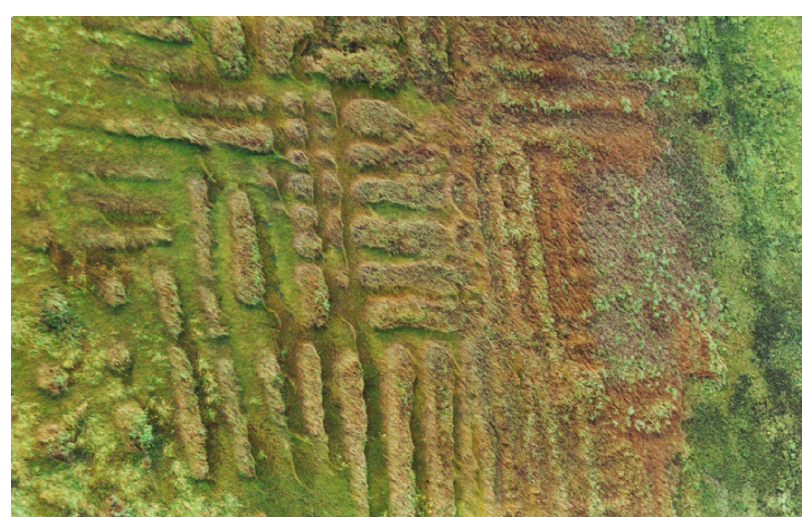
Figure 6. Elongated raised fields.